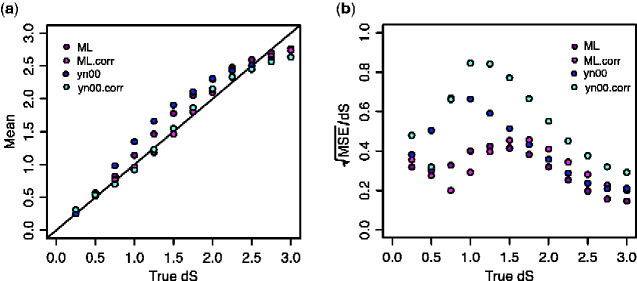
Bias correction for dS estimates in 300-bp windows. (a) The mean of dS estimates using different methods; ML.corr and yn00.corr are the bias-corrected versions of the ML and yn00 methods, respectively. (b) Errors in dS estimates as measured using the ratio of square root of MSE to true dS. All the estimates are based on 10,000 simulations. ML: maximum-likelihood estimates using the f3x4 model in codeml; ML.corr, maximum-likelihood estimates with bias correction; yn00, count-based estimates in Yang and Nielsen (2000); yn00.corr, yn00 estimates with bias correction. All dS estimates are truncated at 3, explaining the reduction in MSE with increasing values of dS as dS approaches 3.